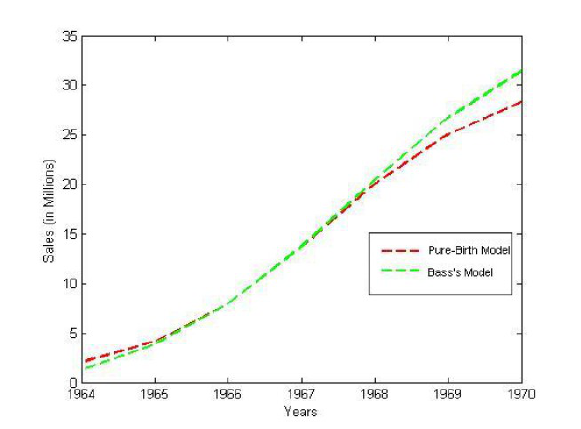
Fig. 3. Prediction of color television sales